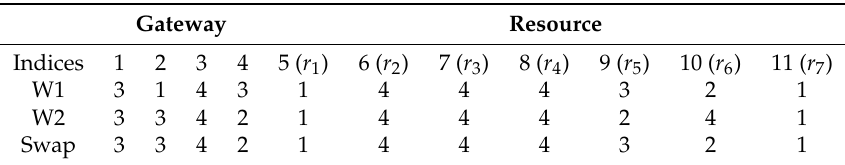
Table 7. An example of swap